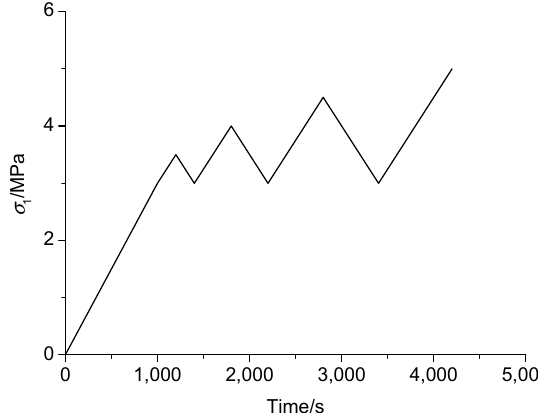
Figure 1. Cyclic loading and unloading path diagram.